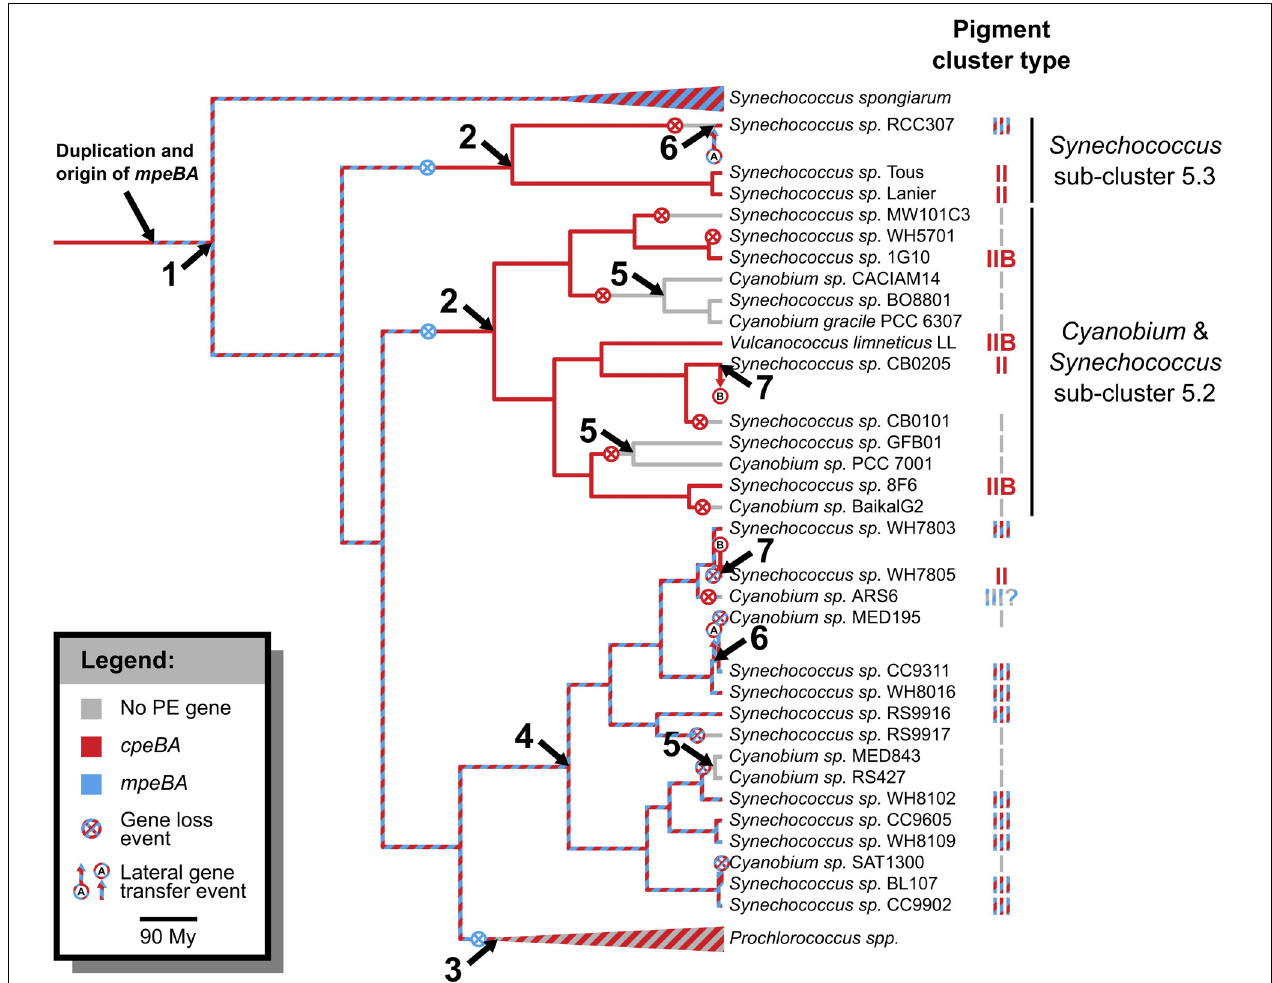
FIGURE 7 | Evolution of pigment clusters in picocyanobacteria. Nodes involving significant events are: (1) The common ancestor of picocyanobacteria and S. spongiarum had a Type III-like pigment cluster, with both PEI and PEII genes, which were retained by S. spongiarum strains; (2) PEII ( mpeBA ) genes were lost in the common ancestor of Sub-cluster 5.3 and in the common ancestor of freshwater Synechococcus species and their close relatives, leaving them with a Type II-like pigment cluster, which diversified into polyphyletic Type II and Type IIB clusters; (3) PEII genes were also lost in the ancestor of Prochlorococcus strains, whose pigment clusters evolved at a very fast pace; (4) PEII genes were retained in the ancestor of marine Synechococcus , most of which have a Type III pigment cluster; (5) Some strains in Sub-cluster 5.2 lost their PEI genes, and some strains of marine Synechococcus lost both PEI and PEII, leaving all of them with a Type I pigment cluster. (6) Synechococcus sp. RCC307 replaced its pigment cluster (probably a Type II) with a Type III pigment cluster; and (7) Synechococcus sp. WH7805 replaced its pigment cluster (probably a Type III) with a Type II pigment cluster originating from an ancestor of Synechococcus sp.